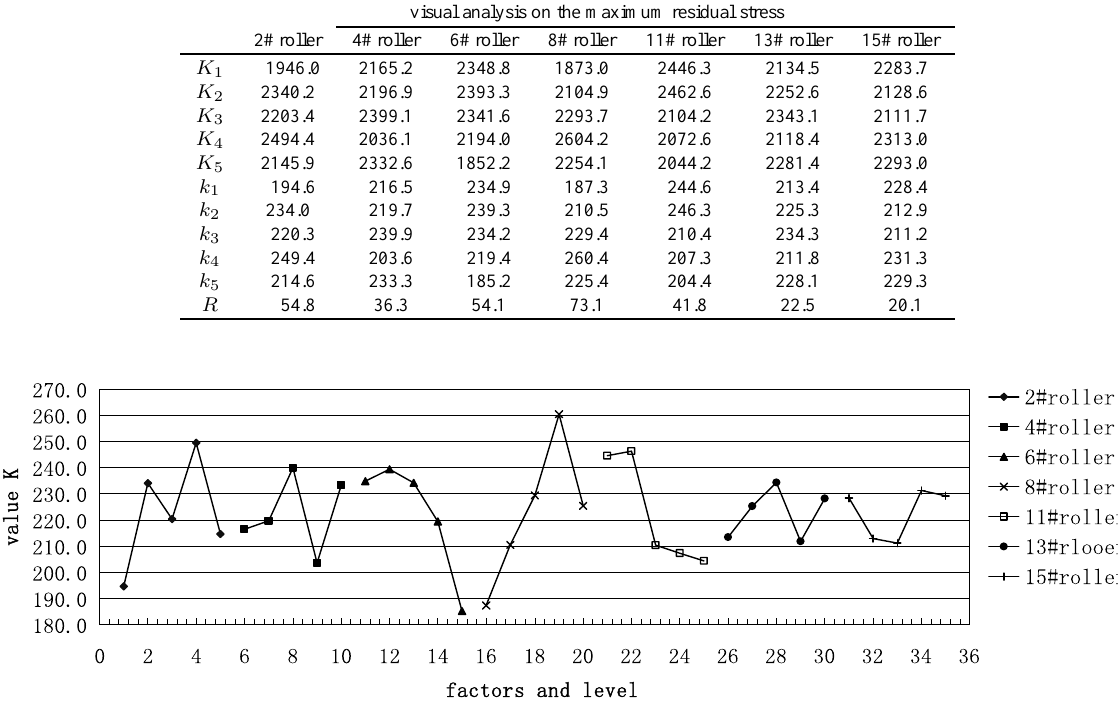
Table 6 The orthogonal analysis diagram of residual stress at rail bottom after compound straightening